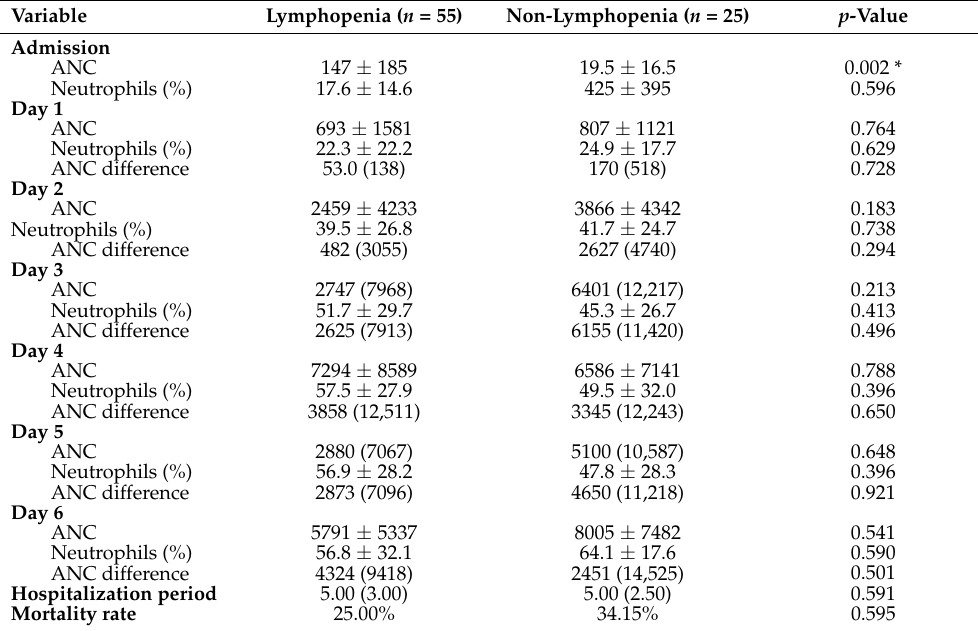
Table 3. Absolute neutrophil count, neutrophil percentage and absolute neutrophil count difference (admission as a reference) among test groups at different follow up points.